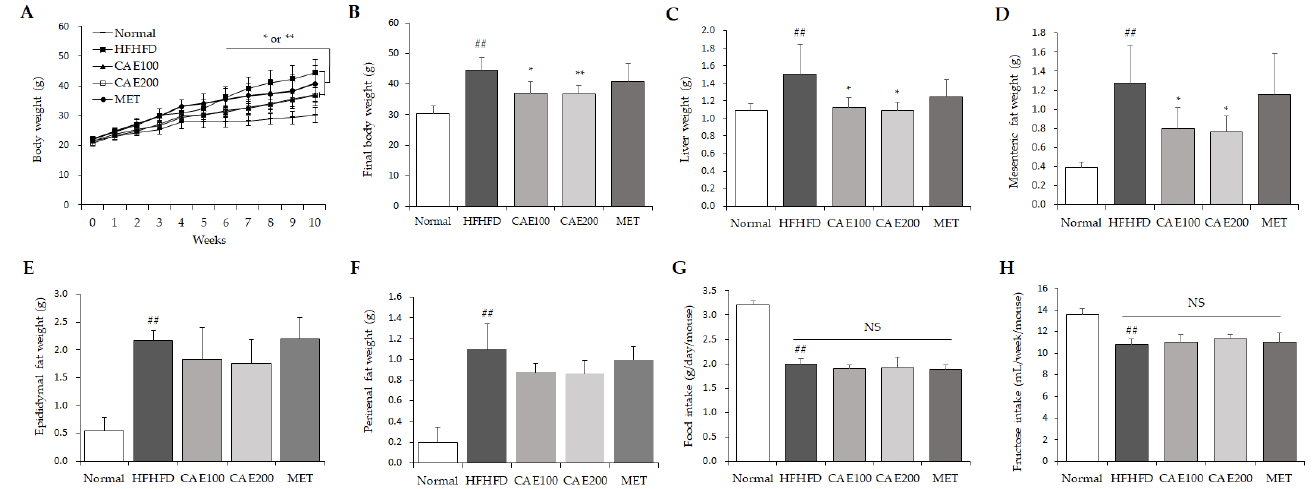
Figure 2. CAE counteracted excessive body, liver, and mesenteric fat mass but did not influence a high-fat diet and high-fructose intake itself. The body weight ( A , B ) and food ( G )/fructose ( H ) intake were recorded once a week throughout the experiment. Liver mass ( C ), mesenteric ( D ), epididymal ( E ), and perirenal ( F ) adipose tissue weights were recorded on the final day (n = 6). ## p < 0.01, as compared to normal group; * p < 0.05 and ** p < 0.01, as compared to the HFHFD group.